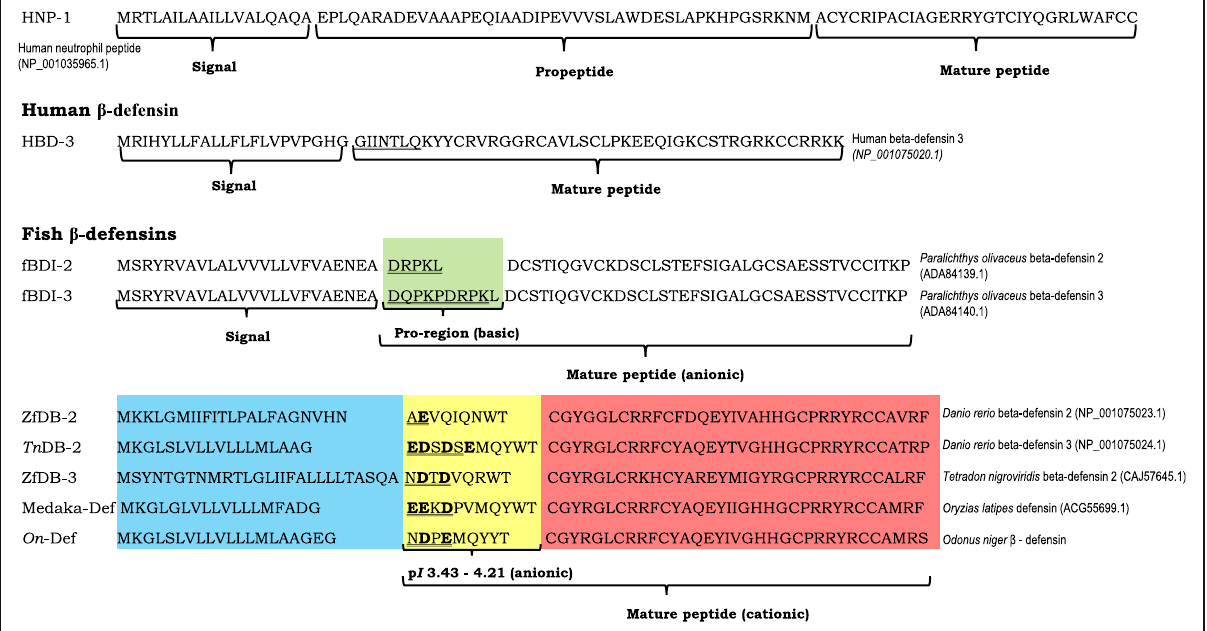
Fig. 8 Comparison of pro-regions (yellow) between signal peptide (blue) and β -defensin domains (red) of various cationic fish-defensins. Anionic residues are marked bold and disordered regions underlined. The basic pro-pieces (green) of two anionic olive flounder β -defensins with disordered regions (underlined) are shown. The disordered regions of HBD3 is